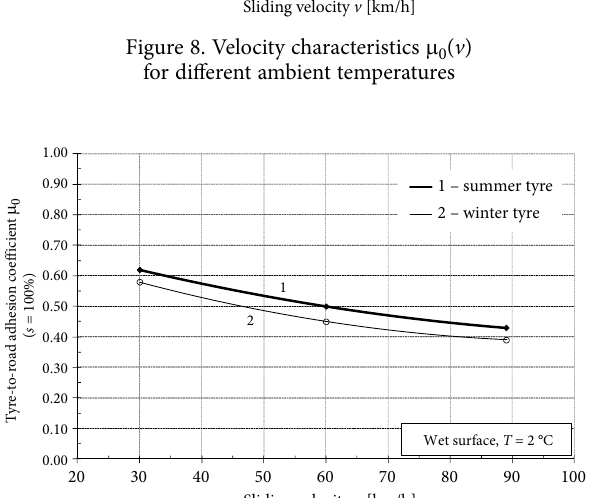
Figure 12. Adhesion characteristics m ( s ) for summer and